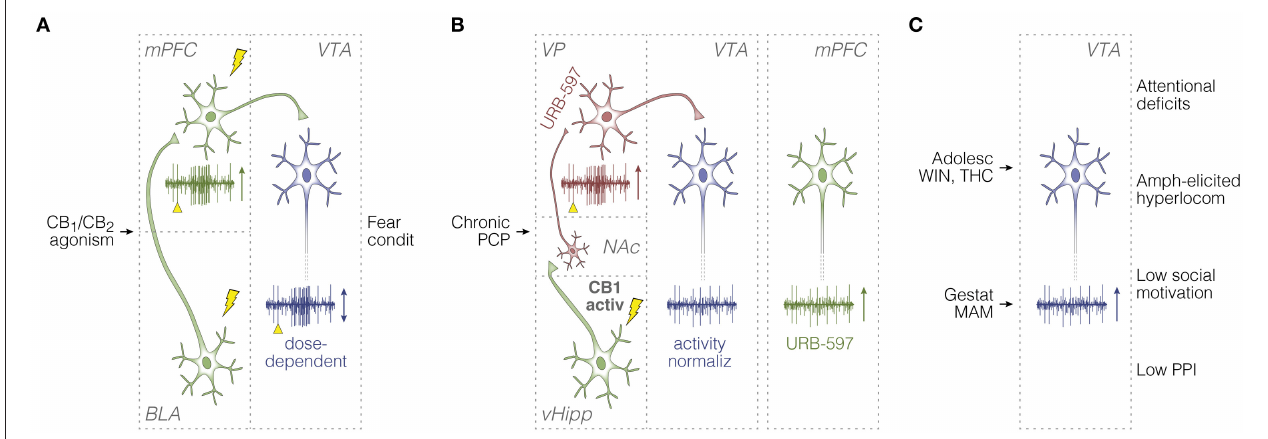
FIGURE 2 | Summary of in vivo unit activity studies in rodents. (A) Afferent stimulation experiments on BLA-responsive mPFC cells (Laviolette and Grace, 2006), and the top-down control of dopamine signaling (Draycott et al., 2014; Melis et al., 2004a). Electrical pulses (lightning icons) and their timestamps (yellow arrowheads) are illustrated along with recording sweeps, and overall effects of cannabinoid manipulations on unit activity responses (vertical arrows). Green and blue neurons are glutamatergic and dopaminergic, respectively. (B) Studies on: (1) CB 1 receptor activation in vHipp (Loureiro et al., 2015, 2016); (2) downstream consequences of vHipp hyperactivity (i.e., abnormal NAc-VP-VTA disinhibition) induced by the chronic PCP model of schizophrenia, and ameliorating effects of anandamide upregulation through FAAH inhibition (URB-597) ( Aguilar et al., 2014); and (3) URB-597 effects on mPFC firing in PCP-treated rats (Aguilar et al., 2016). Red neurons are GABAergic. (C) Studies on behavioral phenotypes and VTA spontaneous activity, either after pubertal cannabinoid exposure, or in the gestational MAM model ( Gomes et al., 2015; Renard et al., 2016). Activ, activation; Adolesc, adolescent; amph, amphetamine; condit, conditioning; BLA, basolateral amygdala; gestat, gestational; hyperlocom, hyperlocomotion; MAM, methylazoxymethanol acetate; mPFC, medial prefrontal cortex; NAc, nucleus accumbens; normaliz, normalization; PCP, phencyclidine; PPI, prepulse inhibition of the acoustic startle; THC, delta-9-tetrahydrocannabinol; vHipp, ventral hippocampus; VP, ventral pallidum; VTA, ventral tegmental area; WIN, WIN